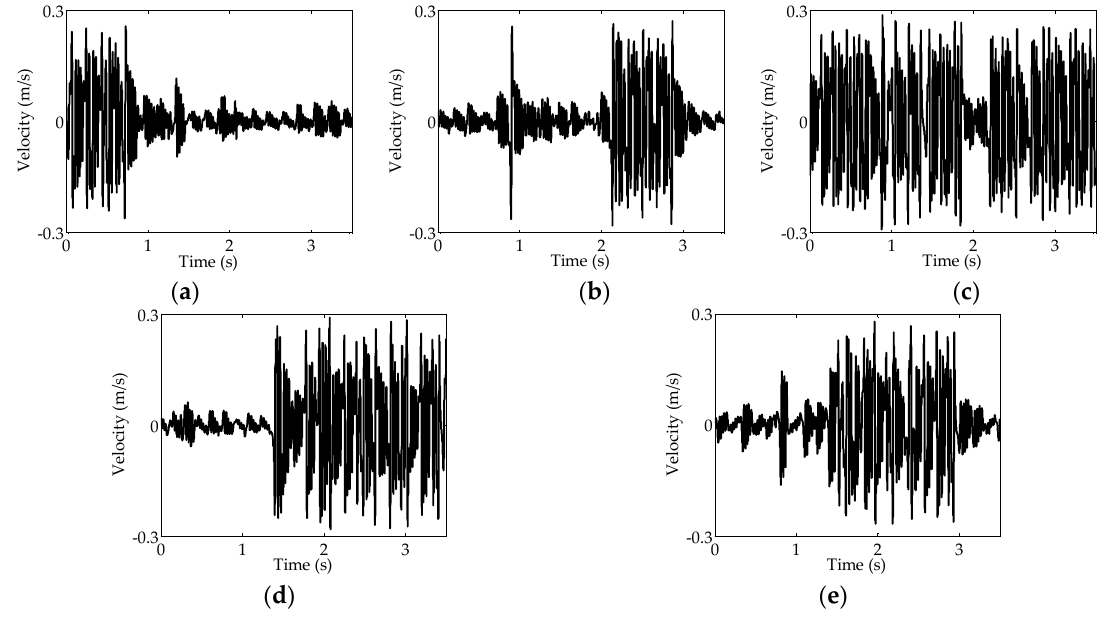
Figure 10. Velocity responses under the on-road noise excitation and the periodic gravity force at the angular frequencies: ( a ) 33 rad/s; ( b ) 35 rad/s; ( c ) 38 rad/s; ( d ) 40 rad/s; ( e ) 42 rad/s.